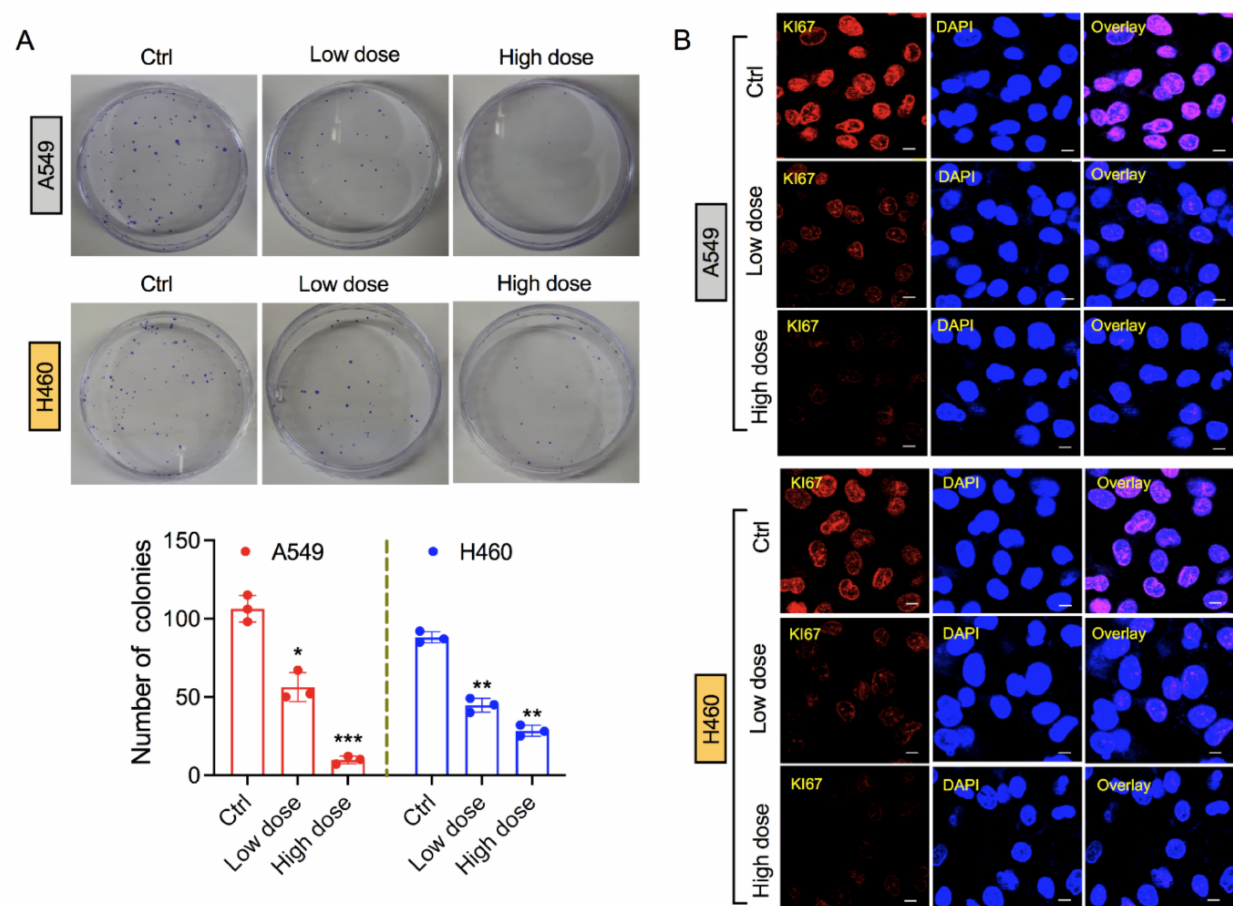
Figure 2. Exposure of 6-aminonicotinamide (6-AN) suppresses the proliferation of lung cancer cells. ( A ) Representative images of colony-forming assays in A549 (upper panel) and H460 (lower panel) stained with crystal violet after indicated doses of 6-AN treatment for 48 h. Graphs indicate the number of colonies formed after each treatment condition in both cell lines. ( B ) Cellular expression of the Ki-67 proliferation marker in A549 and H460 lung cancer cells after 48 h of 6-AN treatment at low (10 µ M) and high (200 µ M) doses. Cells were labeled by immunofluorescence for Ki-67 (red) with 4,6-diamidino-2-phenylindole (DAPI; blue) as the nuclear counterstain. * p < 0.05; ** p < 0.01; *** p <